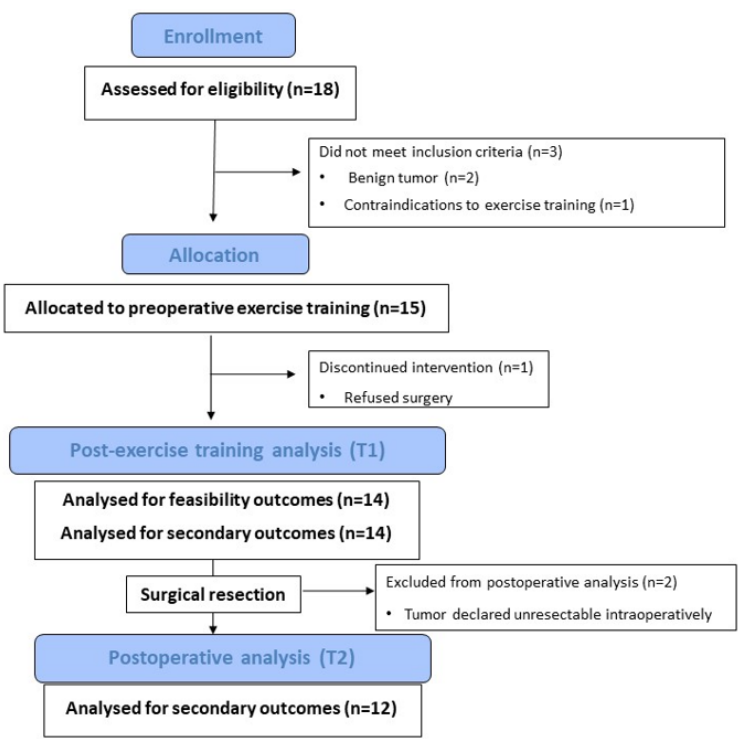
Figure 2. Flow diagram for the study. Table 1. Participant demographic and clinical characteristics.